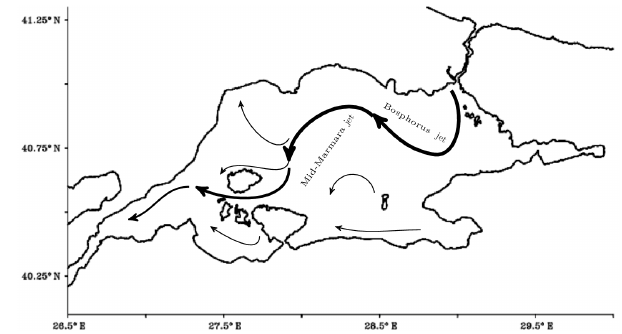
Figure 19. Schematic representation of the surface mean circulation in the Sea of Marmara for the 2009–2013 period. The thickness of curves shows the relative intensity of the associated